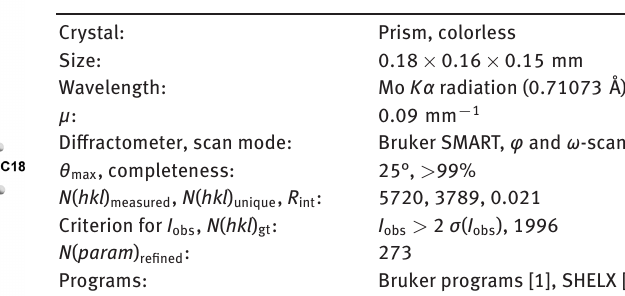
Table 1: Data collection and handling.